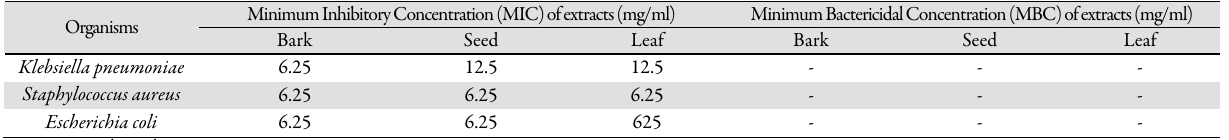
Table 5. Minimum Inhibitory Concentration (MIC) and Minimum Bactericidal Concentration (MBC) of S . aureus , E . coli and K. pneumonia Minimum Inhibitory Concentration (MIC) of extracts Organisms